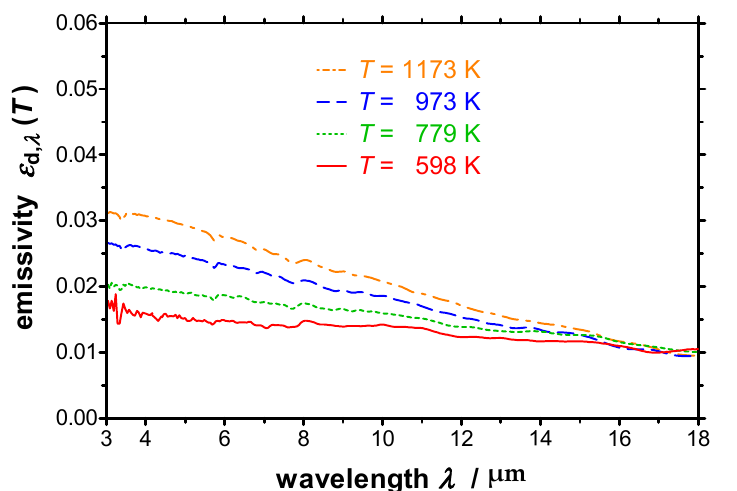
Figure 15. Spectral directional emissivity of polished copper near-normal to the surface measured with the EMMA at different temperatures. The emissivity increases with increasing temperature and with decreasing wavelength.